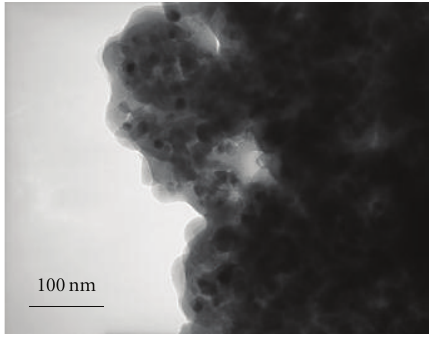
Figure 2: Schematic drawing of mesoporous silica loaded with TiO 2 .